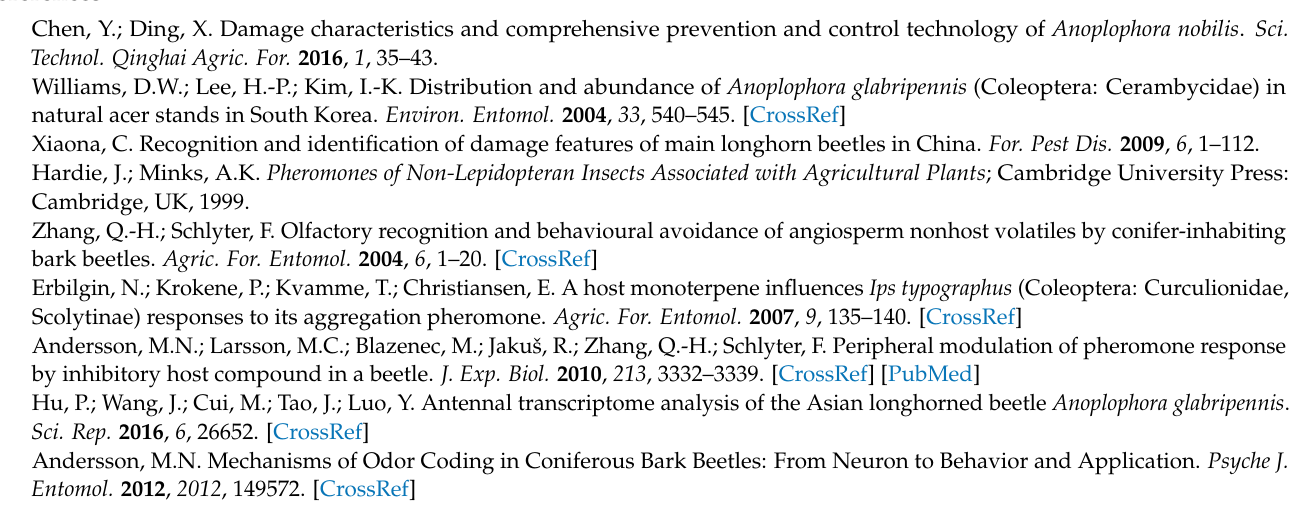
.3390/insects12090787/s1, Figure S1: GO enrichment analysis of each sample between two groups (female vs. male), Figure S2: The statistics of 20 top KEGG pathways of DEGs, Figure S3: The binding curves of (A) of CcreOBP6 and 1-NPN (B) CcreOBP10 and 1-NPN. Table S1: The details of Illumina sequencing identifiers, Table S2: The quality assessment of sample sequencing output data, Table S3: List of splicing length and frequency distribution, Table S4: List of splicing length distribution,